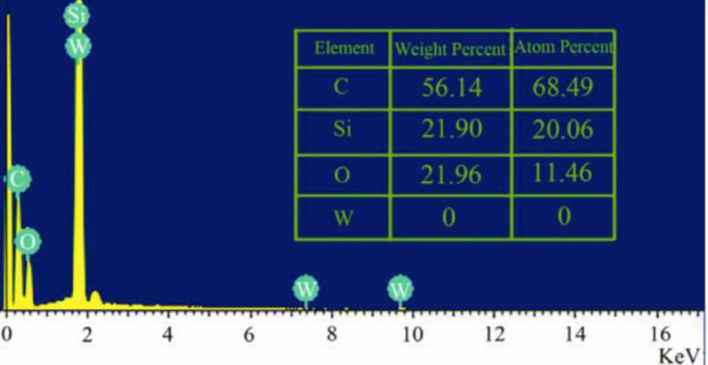
Figure 9. Representation of an EDX spectrum of CDs sample. Reproduced from [188], with permis- sion from Elsevier, 2013.